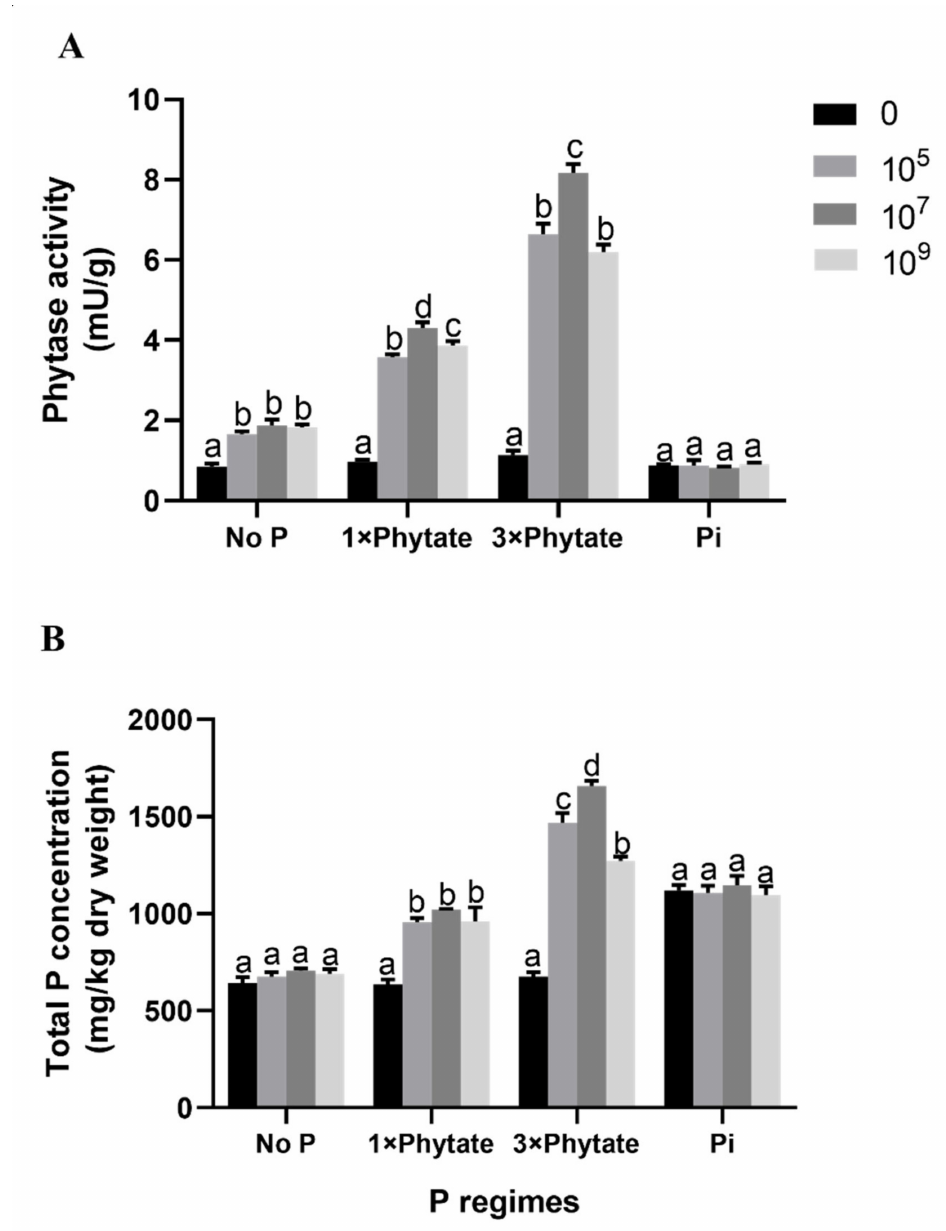
Figure 5. Phytase activity ( A ) in exudates from roots in the rhizosphere and total P concentrations ( B ) of corn plants inoculated with three different concentrations of R. aquatilis JZ-GX1 under four different P regimes in a soil. Different letters indicate statistically significant differences ( p < 0.05) among treatments according to the least significant difference